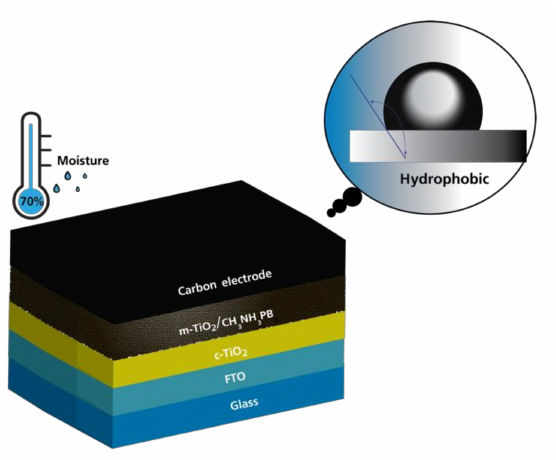
Figure 2. Schematic illustration of the perovskite solar cells and contact angel of H 2 O on carbon. Modified after Huawei Zhou et al., (2014) [46].